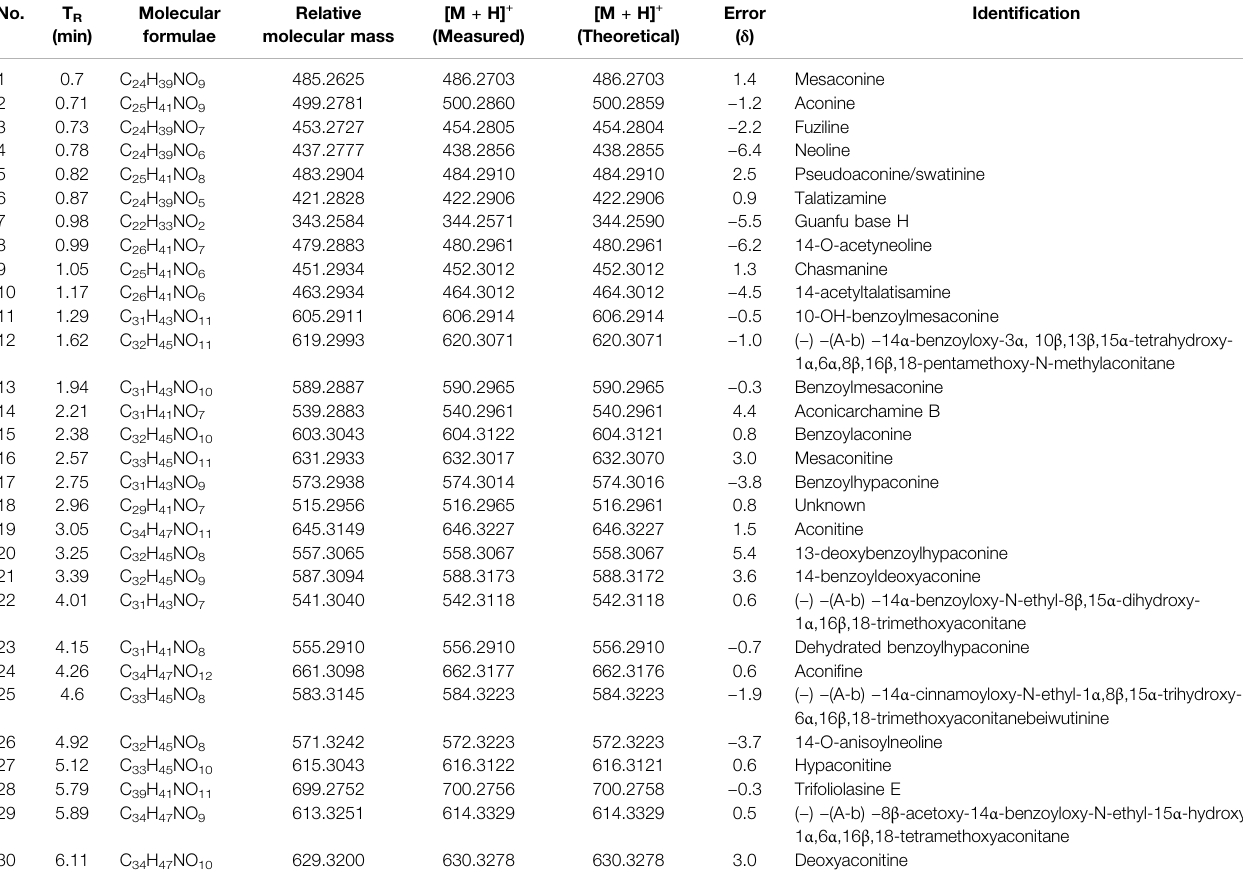
TABLE 1 | Identi fi cation of chemical constituents of Fuzi by UPLC-Q-TOF/MS E . No. T R Molecular (min) formulae